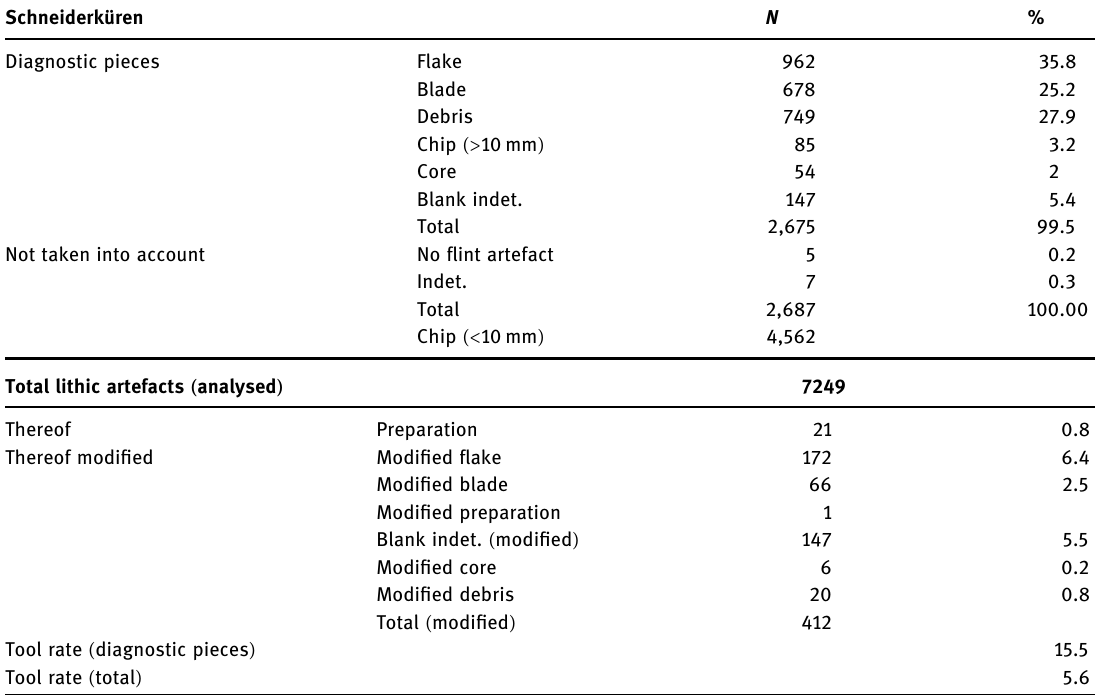
Table 5: Lithic assemblage